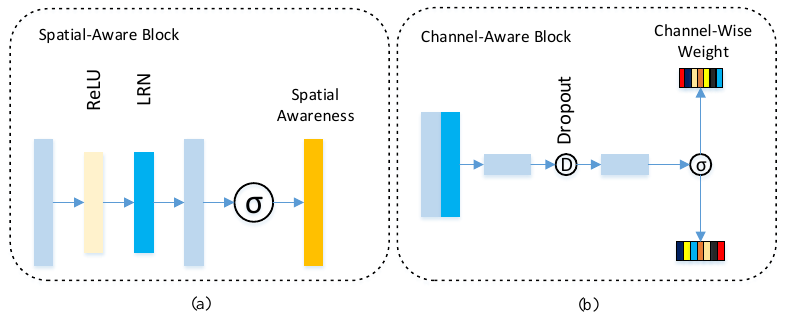
Figure 2. Diagram of spatial-aware block ( a ) and channel-aware multi-modal adaptation block ( b